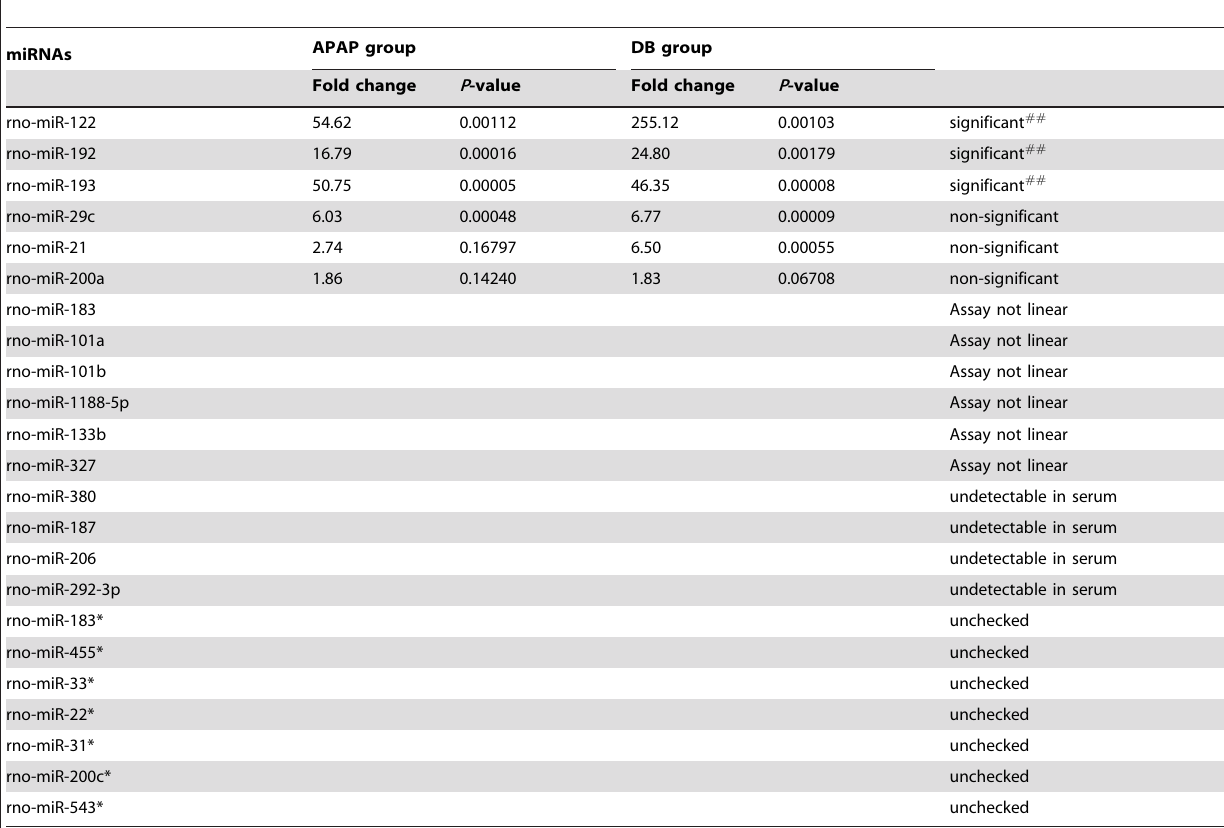
Table 1. qRT-PCR validation of dysregulated serum miRNAs in TLDA results.